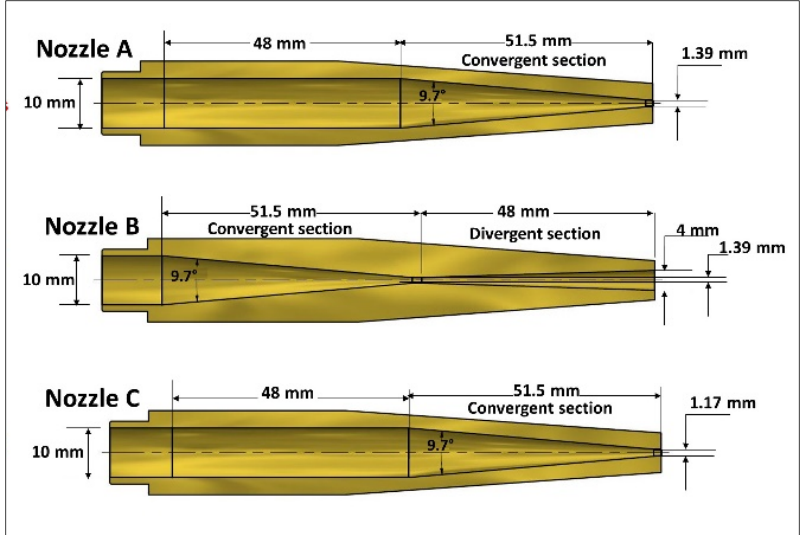
Figure 4. Tested nozzles: nozzle A and C without divergent section, nozzle B with divergent section.